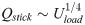
(A) Stick flow rate, Qstick, as a function of loading speed, Uload, for three different sticks and two fluids; the black dashed line shows a trend of Qstick∼Uload1/4, while the blue dashed-dotted line shows the trend Qstick∼Uload3/2. (B) Ratio Qstick/(Dstick2ν1/4) as a function of loading speed, Uload; the prediction of Eq 11 is shown by the dashed-dotted line.